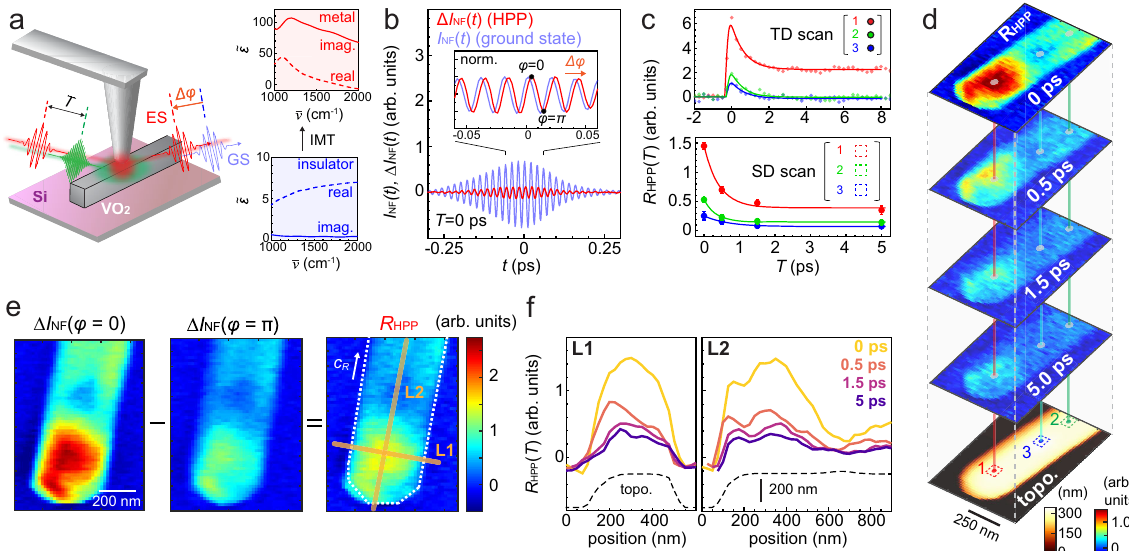
Fig. 3 Phase-controlled ultrafast nanoimaging of insulator-to-metal transition in a VO 2 nanobeam. a Schematic of NIR pump (1.2 eV, ~2 mJ/cm 2 ) infrared-probe (0.2 eV) ultrafast nanoimaging of VO 2 (left) probing the complex dielectric functions of the insulator and metallic states (right, adapted from a complex refractive index measurement by Wan et al. 53 ). b Time-domain HPP near- fi eld interferogram acquired on a VO 2 nanobeam at T = 0 ps, with the shifted phase between the ground-state I NF ( t ) and the photoinduced state Δ I HPP ( t ) (inset). c The HPP signal amplitude relaxation R HPP ( T ) measured by the two-phase T -dependent (TD) scans at selected locations (top) and the equivalent acquired based on space-domain (SD) scans (bottom). d Ultrafast HPP nanoimaging of the VO 2 nanobeam with the AFM topography. e The HPP amplitude mapping at T = 0 ps, derived from mappings at the two E LO phases, ϕ = 0 and π . f Time-dependent evolution of the HPP signal along L1 and L2 in panel e with the corresponding topography of the